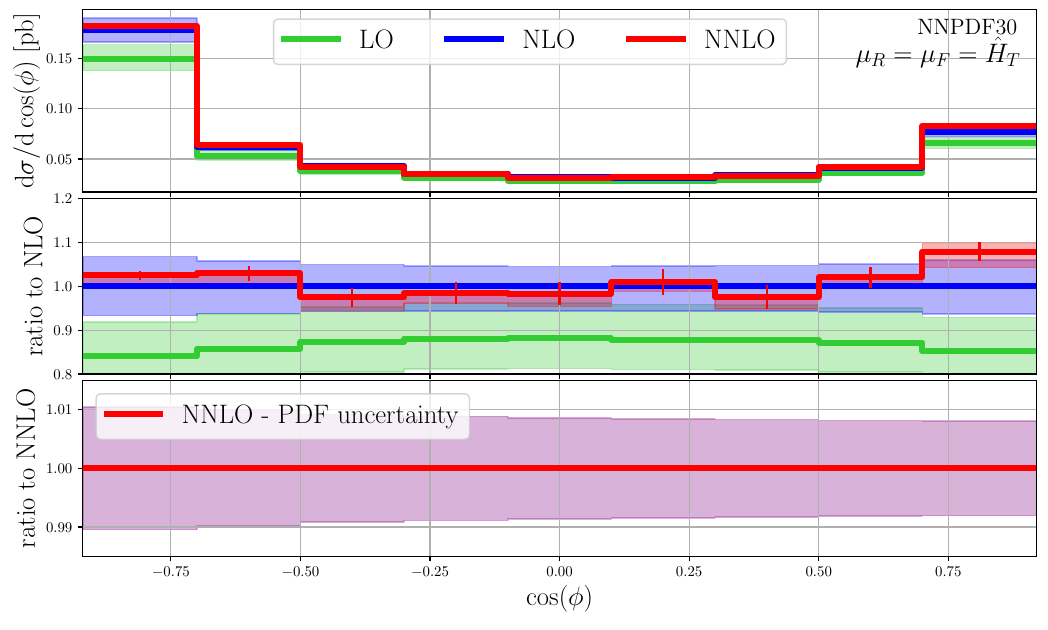
Figure 4 . The TEEC variable in the inclusive H T, 2 ≥ 1 TeV bin. The top panel shows the absolute differential distribution through LO (light green), NLO (blue) and NNLO (red) QCD. The coloured bands show the scale uncertainty estimates and vertical bars indicate statistical uncertainties. The second panel shows the ratio to the central NLO QCD prediction. The third panel shows the PDF uncertainty estimate from NNPDF30 at NNLO